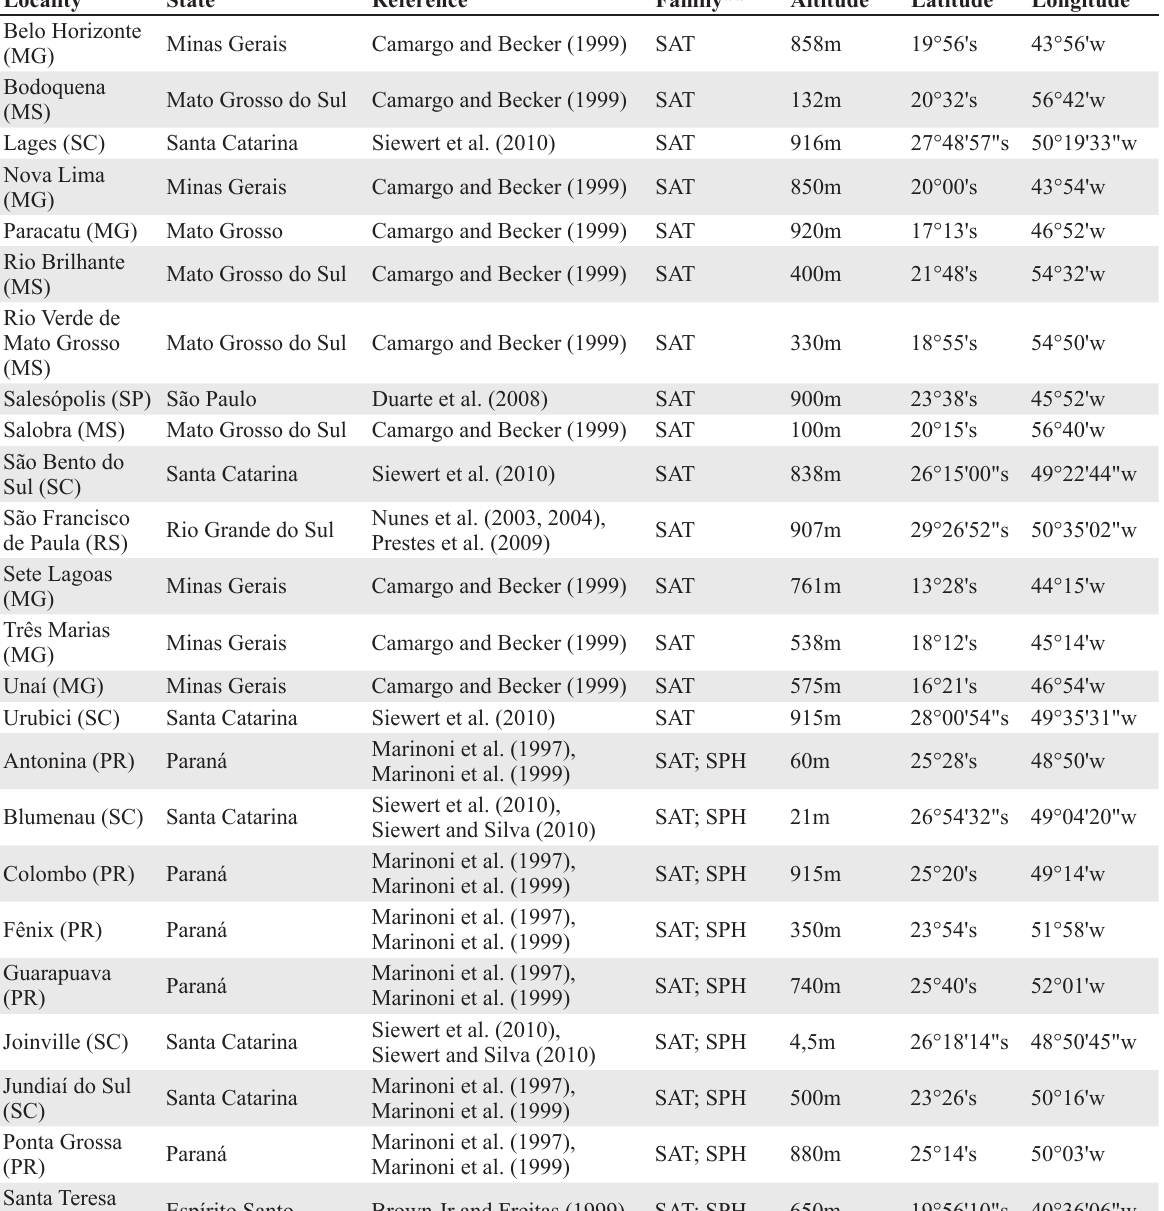
Checklist of the localities with inventories that were used to compare with the fauna of Tijucas do Sul, Vossoroca, Paraná,